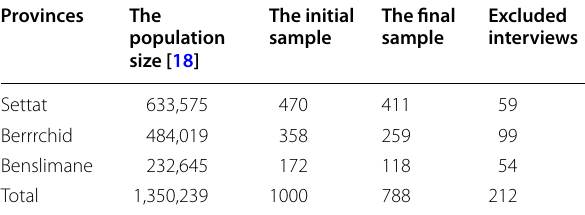
Table 1 Sample distribution by